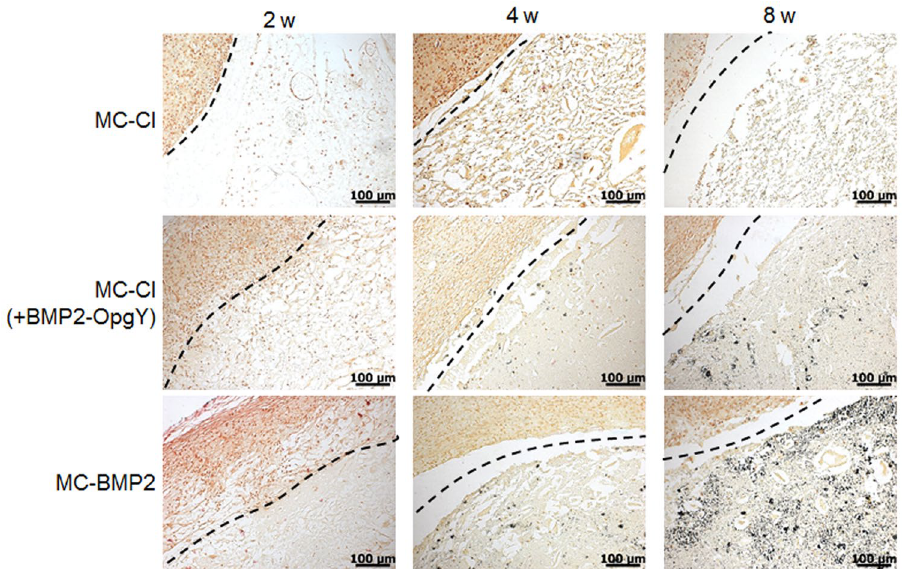
Figure 9. Von Kossa-stained histological sections of engineered bone from mice implanted with human periodontal ligament stem cells on MC-Cl, MC-Cl ( + BMP2-OpgY), or MC-BMP2 hydrogels removed after 2, 4, or 8 weeks (magnification 200 × , scale bars represent 100 μ